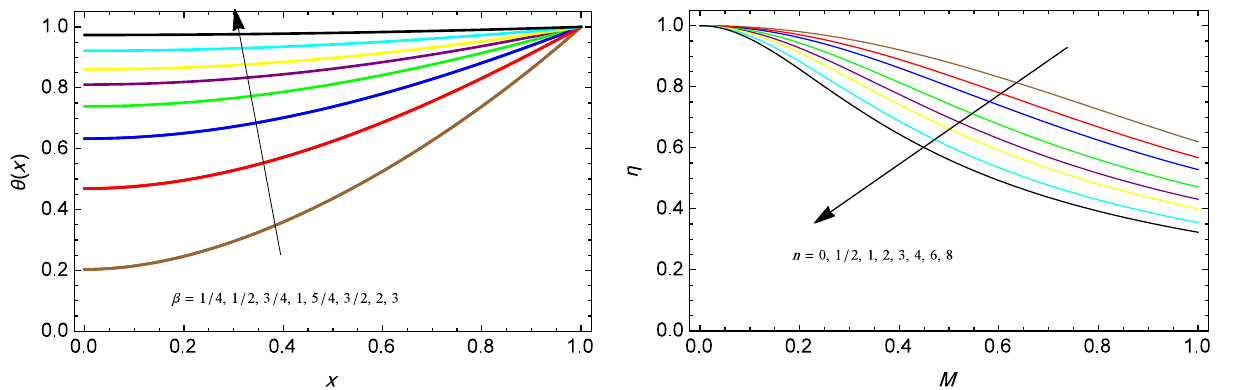
Figure 2: Diagram of θ x ( ) versus x for temperature distributions with M 1 = and n 1 = . 3